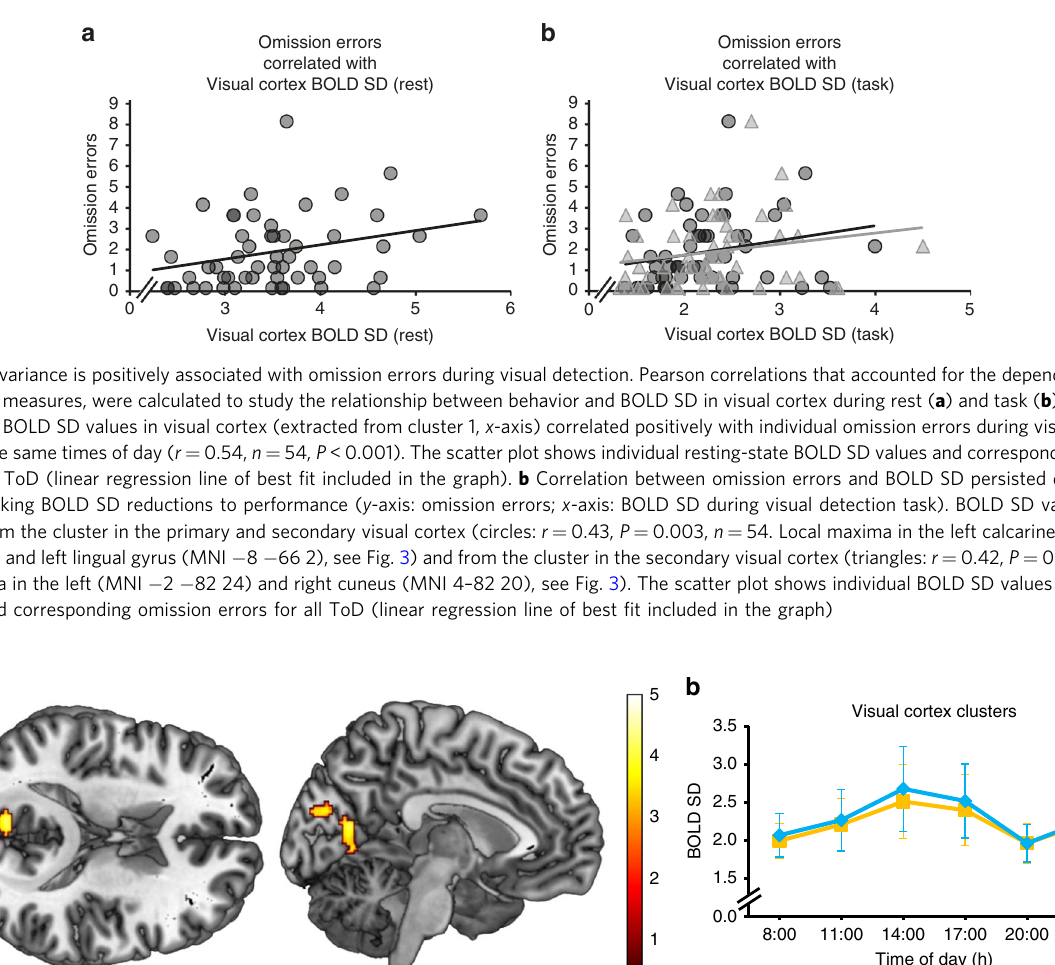
times, compensating for the environmental visual constraints, may thus have been crucial for survival until the introduction of electric light sources into social life 35 . Beyond this vital importance, our fi ndings may represent a new generic mechanism underlying improved perception of close-to-threshold sensory input.